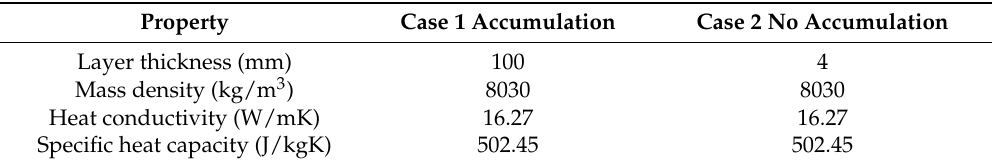
Table 1. The property material of the steel circular wall (inner pipe diameter is 0.6